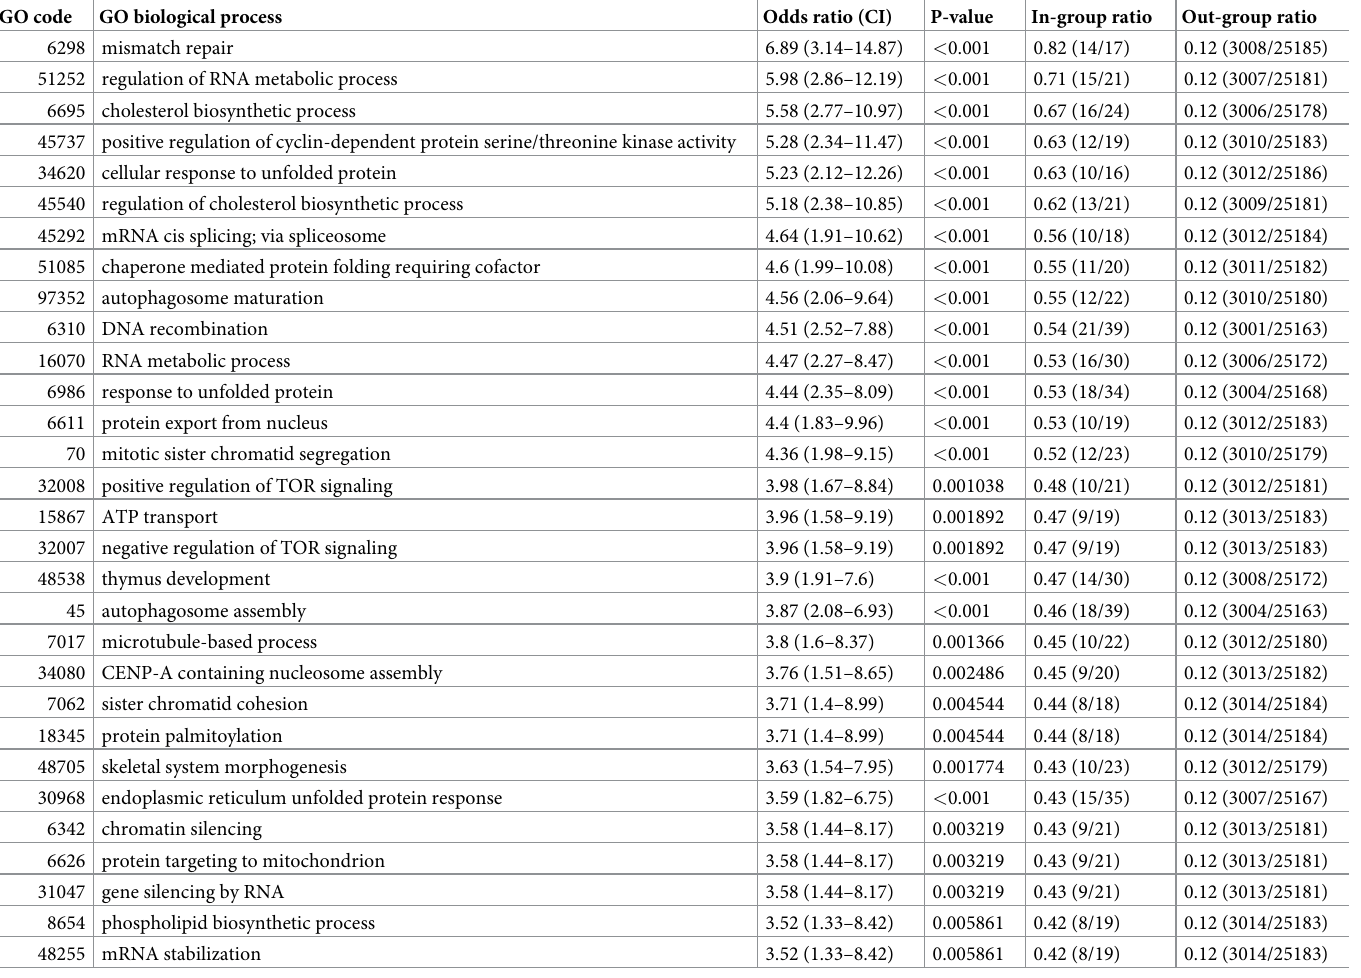
Table 1. Biological processes with the highest enrichment in genes containing estimated SRE-NFY